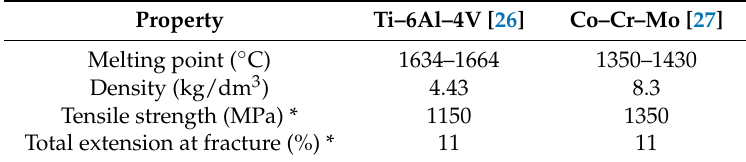
Figure 1. Tensile specimen. Dimensions are expressed in millimeters. Table 1. Nominal physical and mechanical properties of the two alloys.